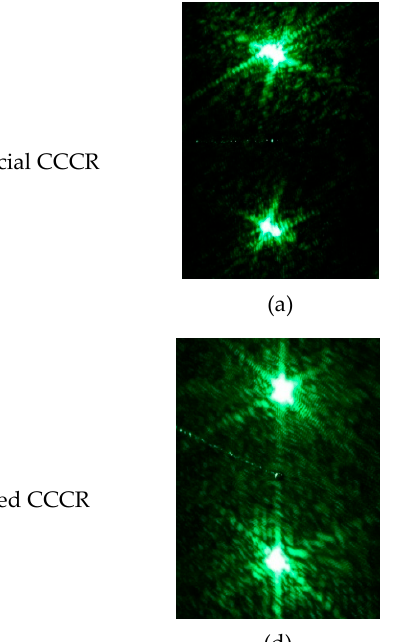
Figure 20. The prototyped SuperPin CCCR of the optimized design.